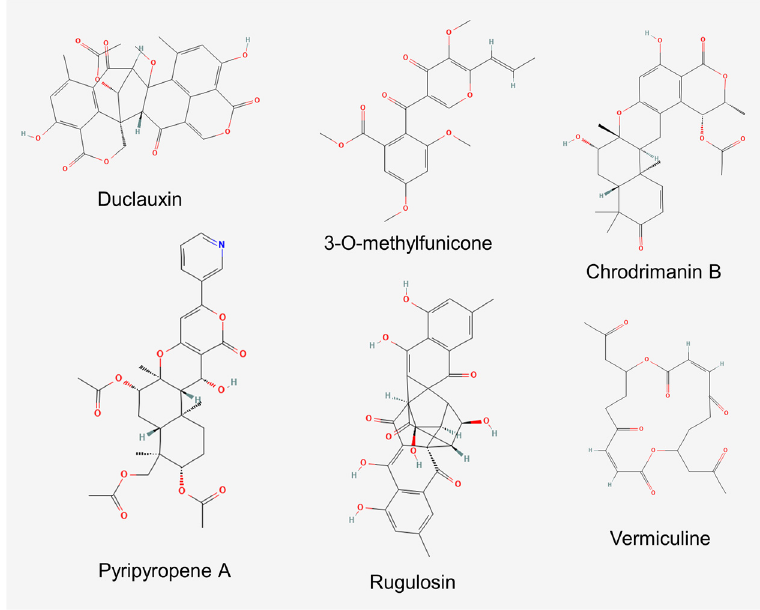
Figure 1. Molecular structure of anti-insectan products of Talaromyces spp.